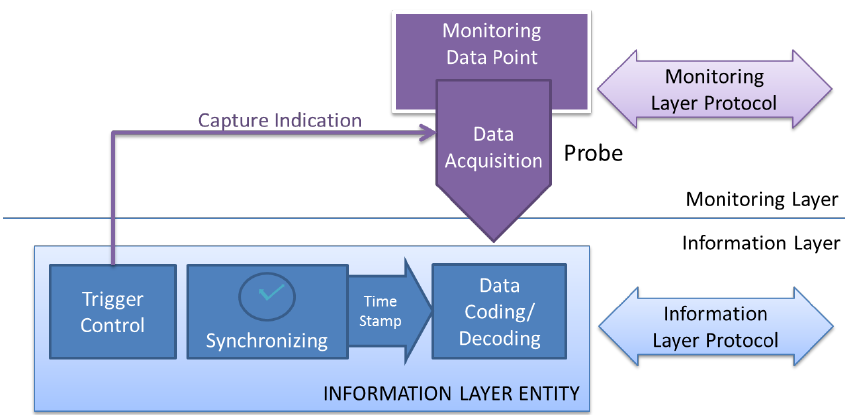
Figure 3. MDP, Probe and Information Layer Entity.